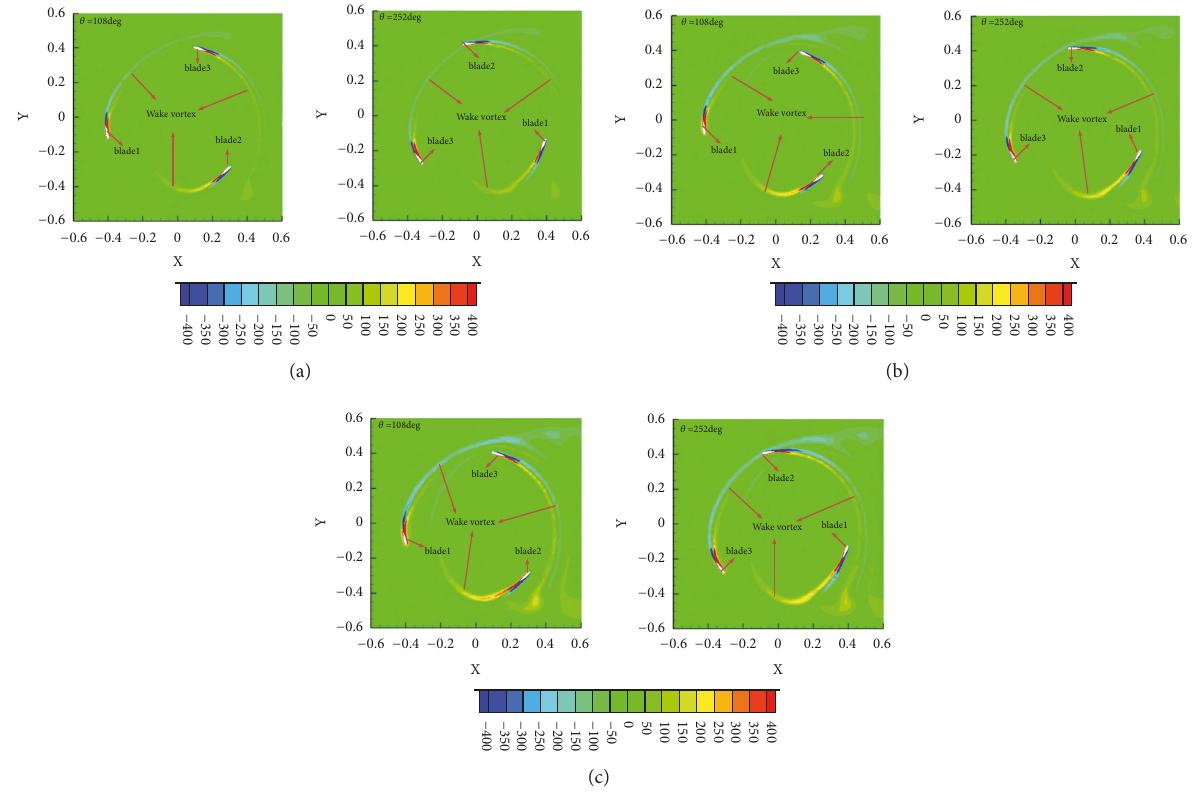
Figure 11: The vortices contours of H-VAWT under three considered Reynolds number at 𝜓 =0.25, (a) Re = 3.41 × 10 5 , (b) Re = 5.12 × 10 5 , and (c) Re = 6.82 × 10 5